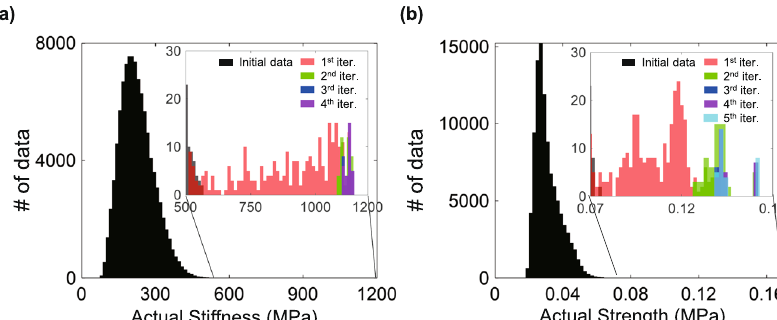
Fig. 7 Histogram of optimization results. Histogram of ( a ) stiffness and ( b ) strength after the optimization. The initial dataset are colored black, the data from 1st, 2nd, 3rd, 4th, and 5th updates of DNN are colored red, green, blue, purple, and cyan,